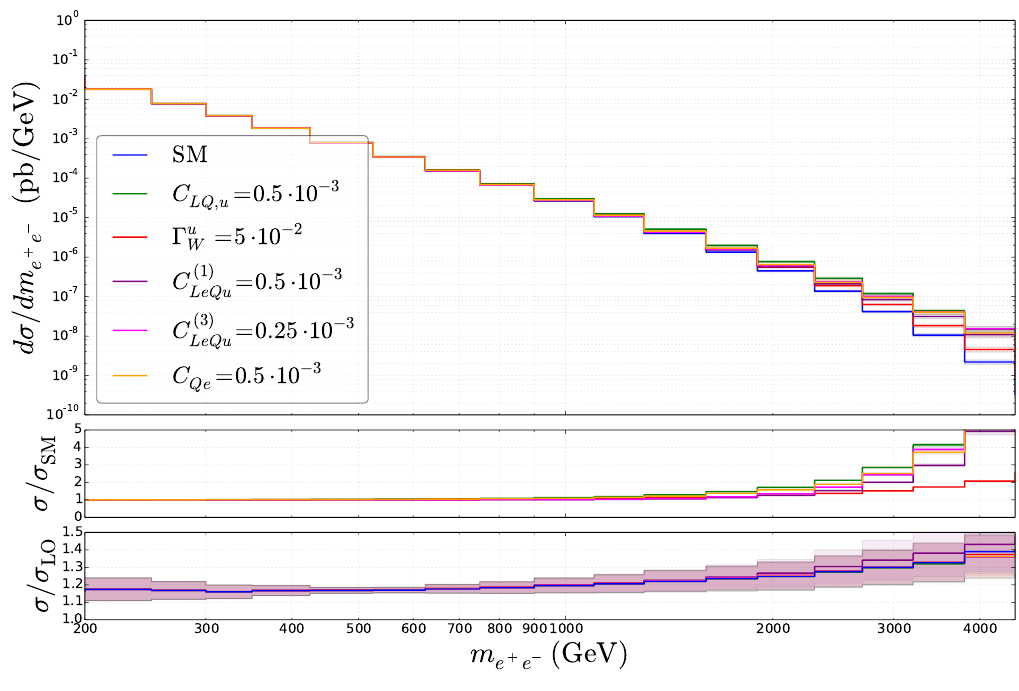
Figure 2 . Di(cid:11)erential pp ! e + e (cid:0) cross section as a function of the dilepton invariant mass, p at S = 13 TeV. The shaded regions indicate the theoretical uncertainties from PDF and scale